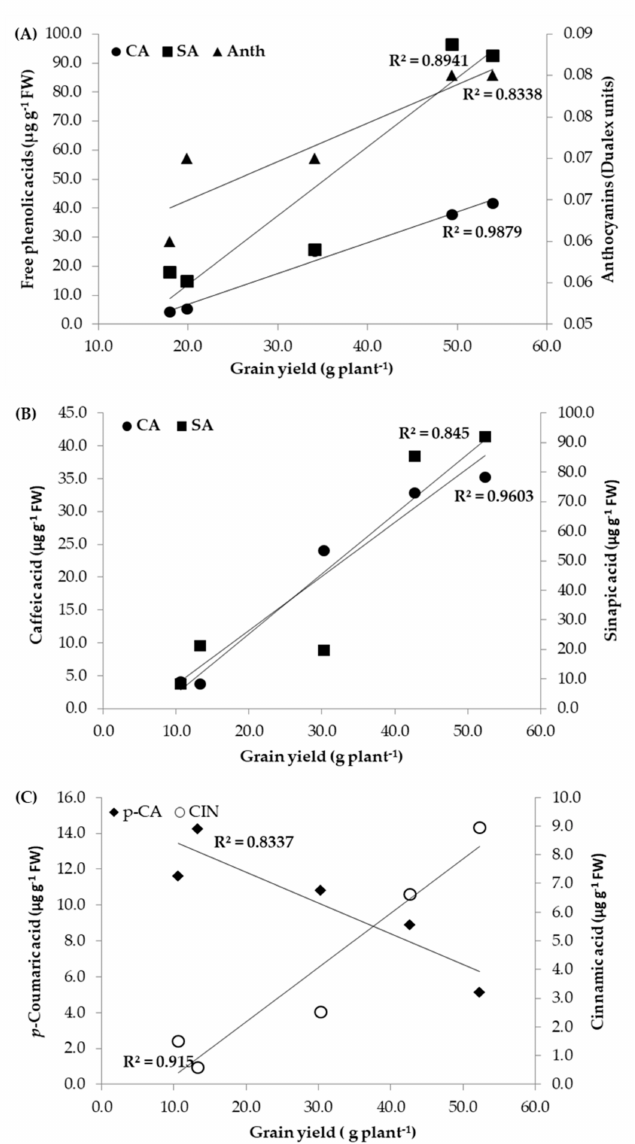
Figure 4. Pearson regression coefficients for the correlations: ( A ) between grain yield and the anthocyanins index and caffeic (CA) and sinapic acid (SA) obtained under I 75 irrigation treatment; ( B ) between grain yield and caffeic (CA) and sinapic acid obtained under I 0 –non-irrigation treatment; ( C ) between grain yield and p -coumaric acid ( p -CA) and cinnamic acid (CIN) obtained under I 0 –non- irrigation